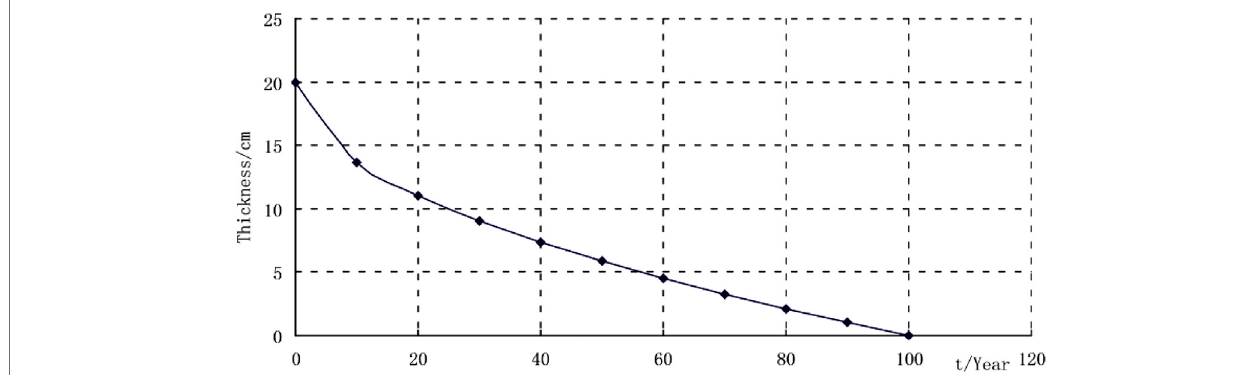
FIGURE 5 | Variations in deterioration thickness of the shotcrete with time.